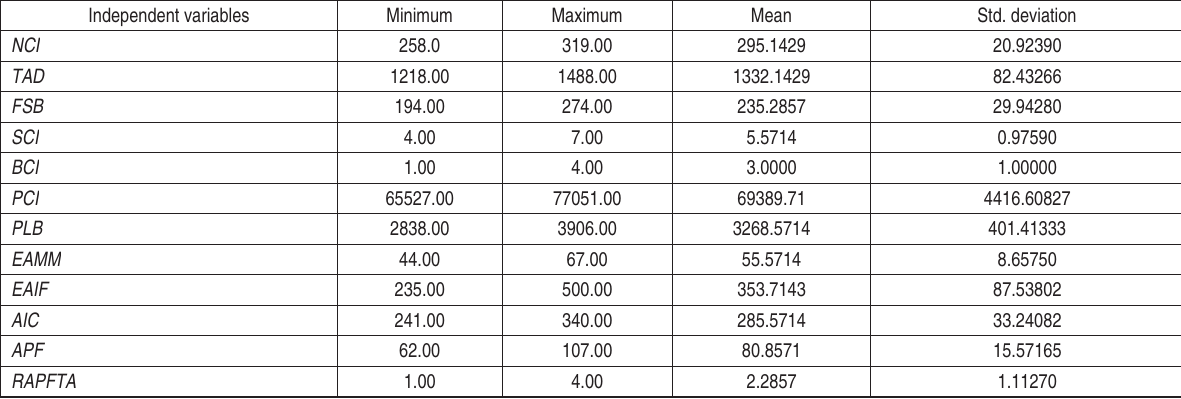
Table 1. The statistical descriptive analysis of independent